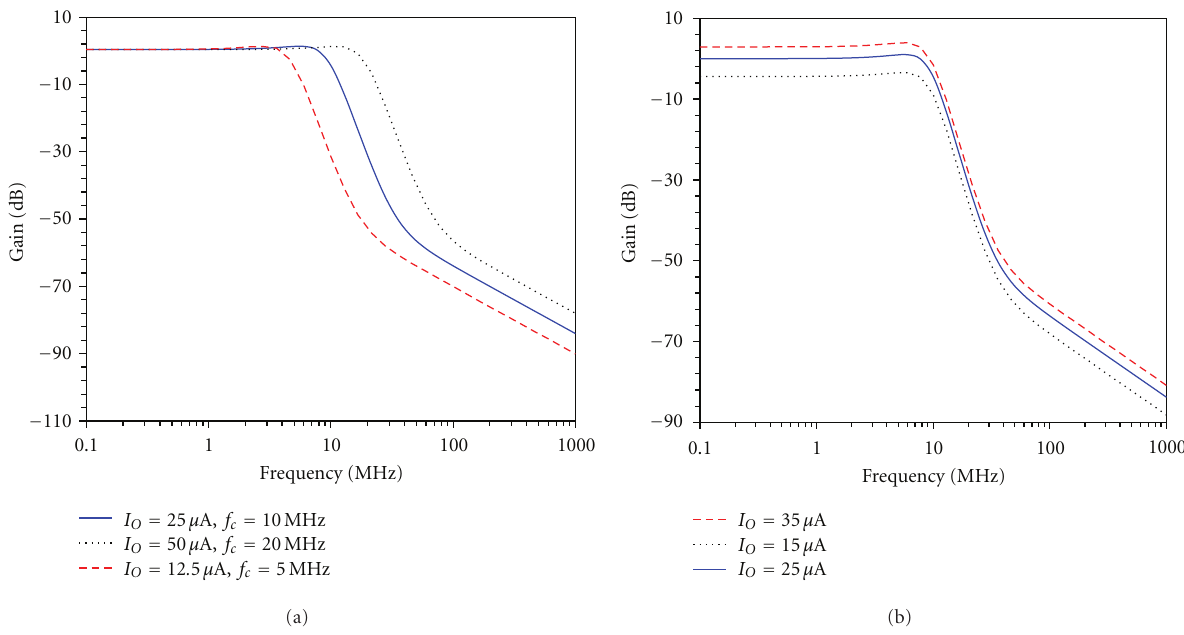
Figure 8: Demonstration of electronic tunability of cut-o ff frequency and gain of MFFs.